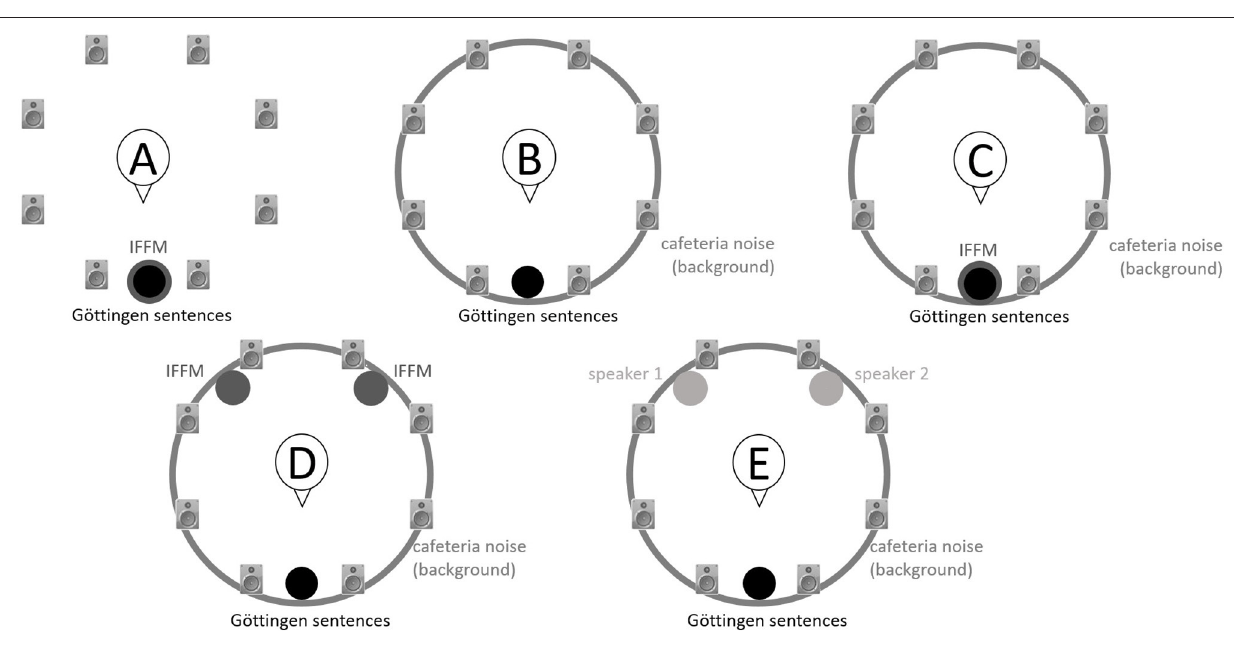
listener’s position and attenuated internally to the presentation level of 65 dB SPL (speech signal). Calibration signals were